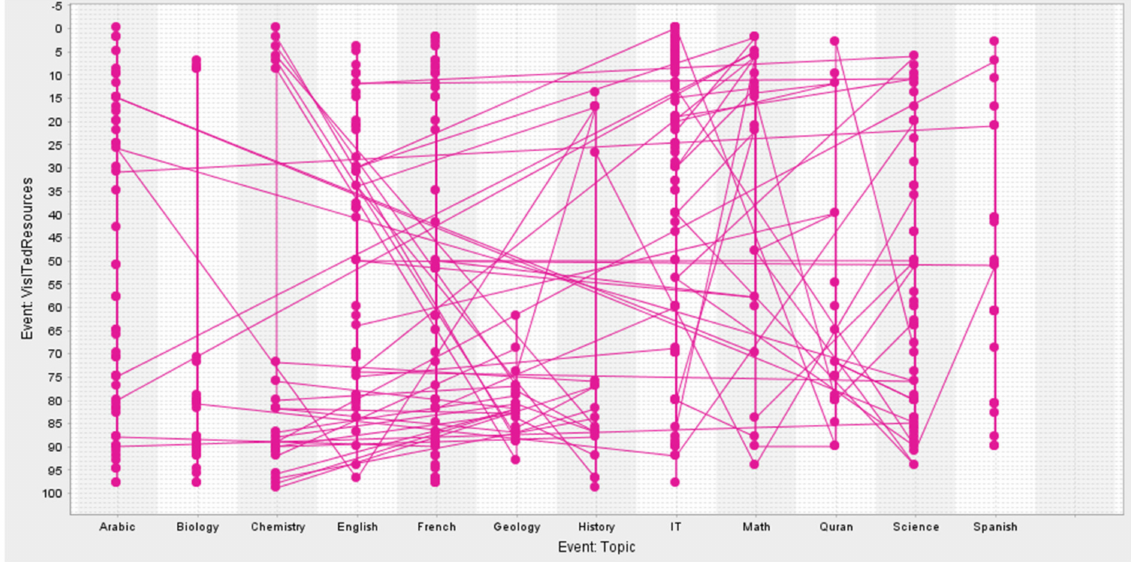
Figure 8. Dotted chart showing the connections between topics and the resources visited by